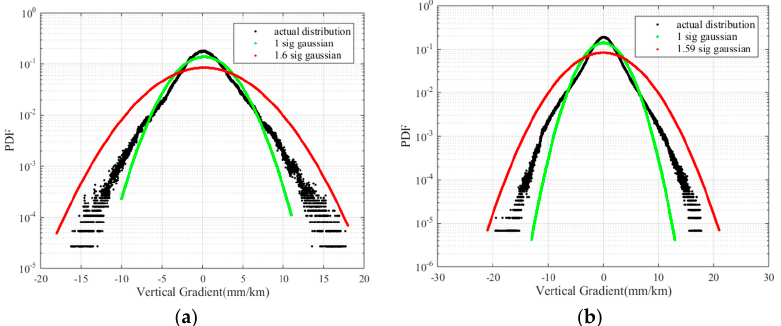
Figure 12. ( a ) Normalized vertical ionospheric gradients on DOY 083; ( b ) Normalized vertical ionospheric gradients on DOY 095.